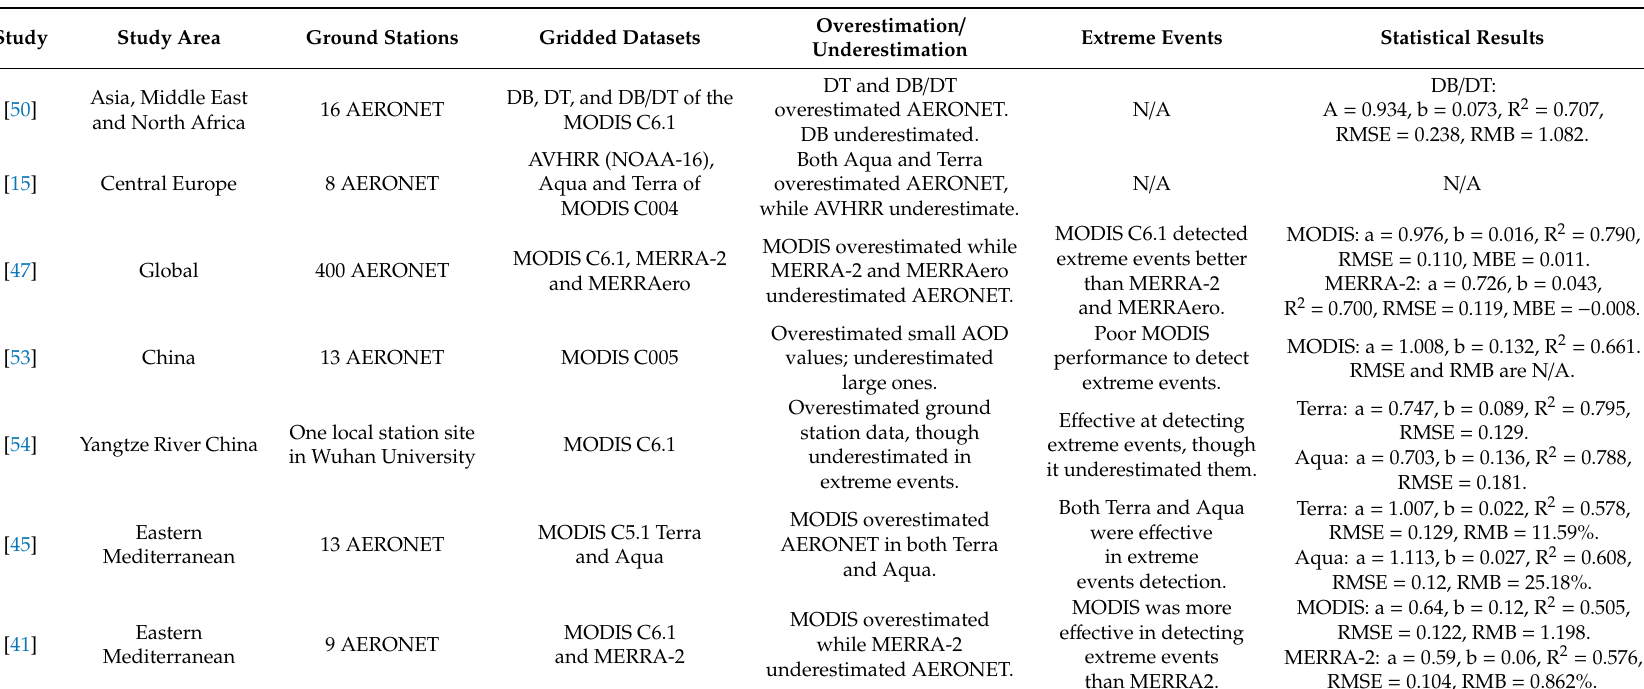
Table A2. Comparison of a results of seven previous studies that were conducted over Europe, Asia, Middle East, and Africa. Comparison was done by the mean of (i) Study area, (ii) Number of ground stations included sites, (iii) Used gridded datasets, (iv) Overestimation and underestimation of ground station data by gridded data, (v) Ability of gridded data to detect extreme events that were measured by the ground stations, and (vi) Brief statistical numeric of the whole dataset regression of gridded data as a function of ground stations